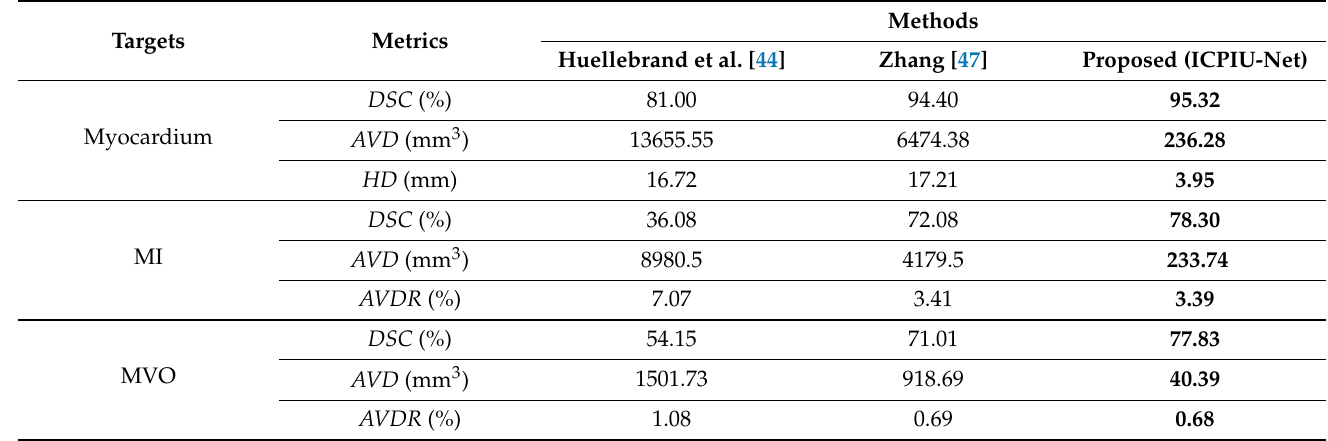
Table 3. A comparison of evaluation methods on 5-fold cross-validation of EMIDEC dataset. Best values are marked in bold font.